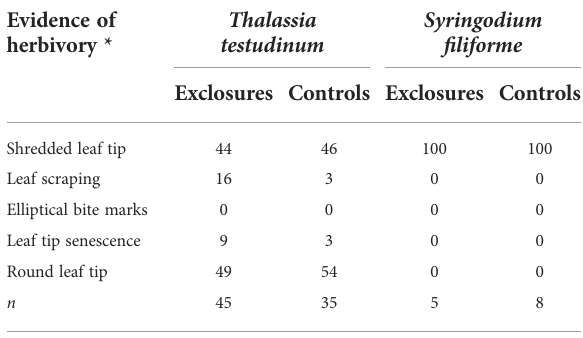
TABLE 3 Evidence of herbivory (%) on seagrass leaves within exclosures and control plots per species following a 13-month megaherbivore exclusion experiment at Cahuita National Park, Costa